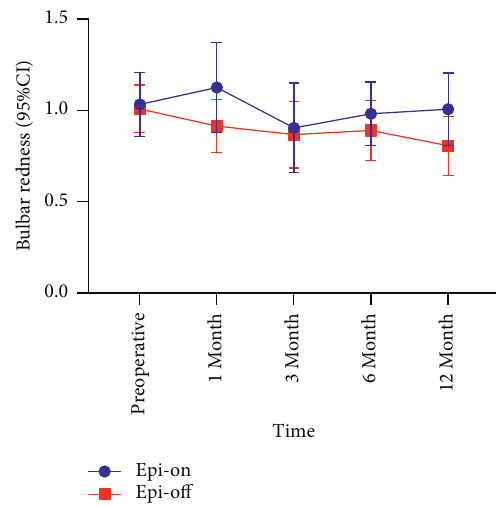
Figure 7: Comparison of the bulbar redness during the 12-month follow-up period. CI: confidence